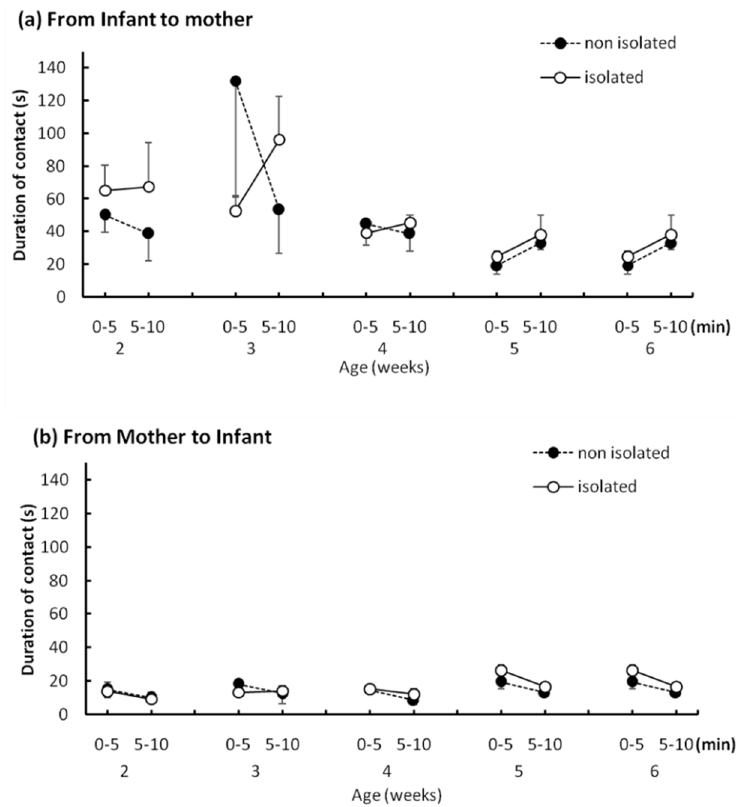
Figure 6. The mean duration of contact initiated by infant to mother ( a ) and mother to infant ( b ). Error bars indicate the standard error.